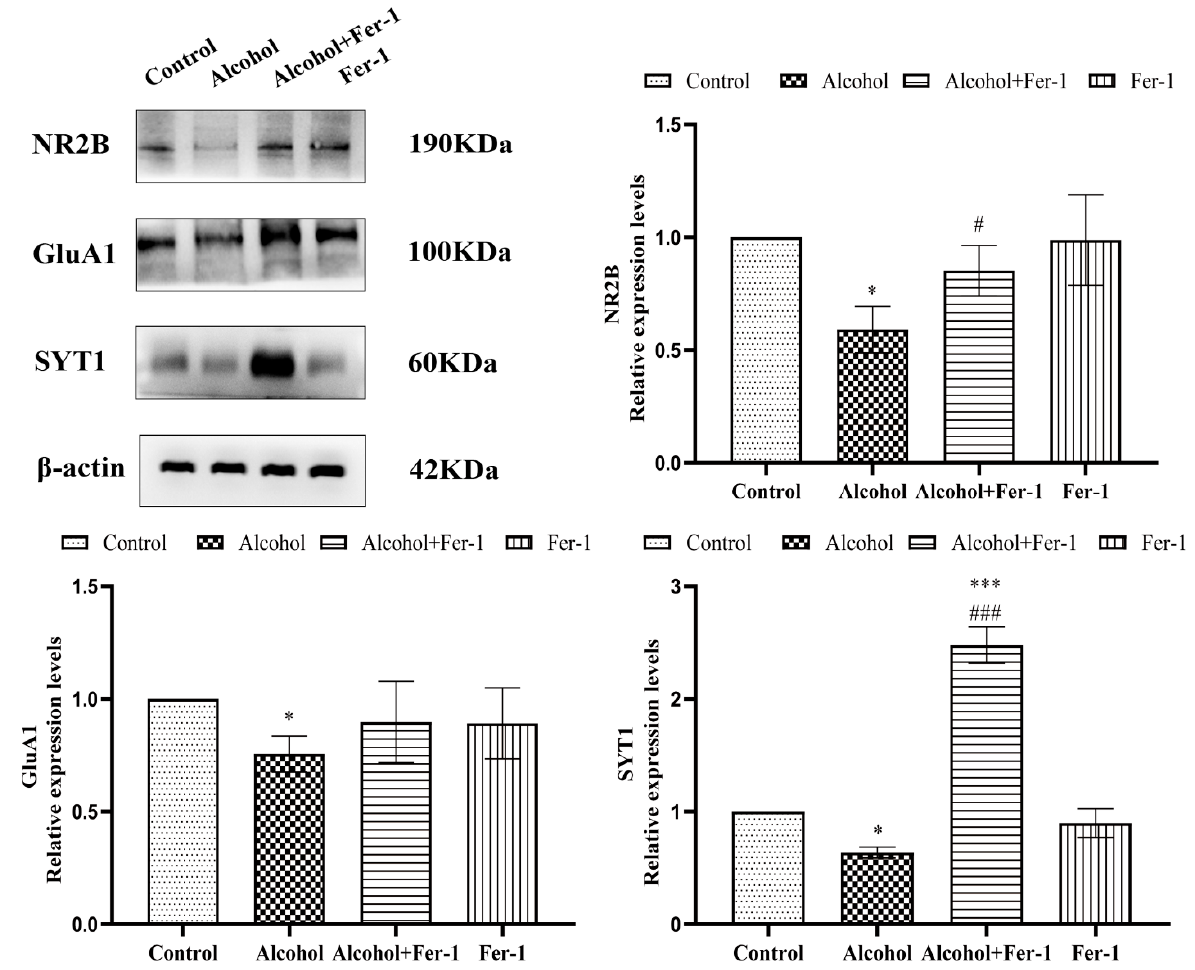
Figure 7. Inhibition of ferroptosis ameliorated synaptic plasticity. Protein expressions of NR2B, GluA1, and SYT1 were analyzed by Western blot. Data are presented as the mean ± SEM. Statistical analysis was carried out by one-way ANOVA for multiple comparisons with Tukey post hoc test, * p < 0.05, *** p < 0.001 vs. control group; # p < 0.05, ### p < 0.001 vs. alcohol group.